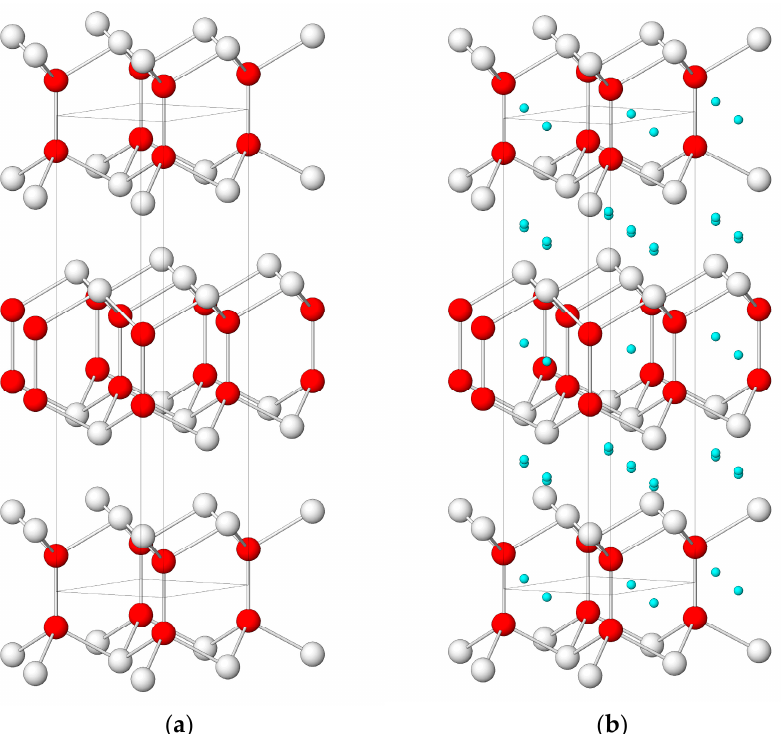
Figure 2. A typical unit cell of layered graphite-like materials (gallium (indium) monoselenides) before ( a ) and after hydrogen penetration into the crystal layer (proton—•) and in the interlayer (molecules—••) spaces (hydrogen nanocontainer) ( b ).